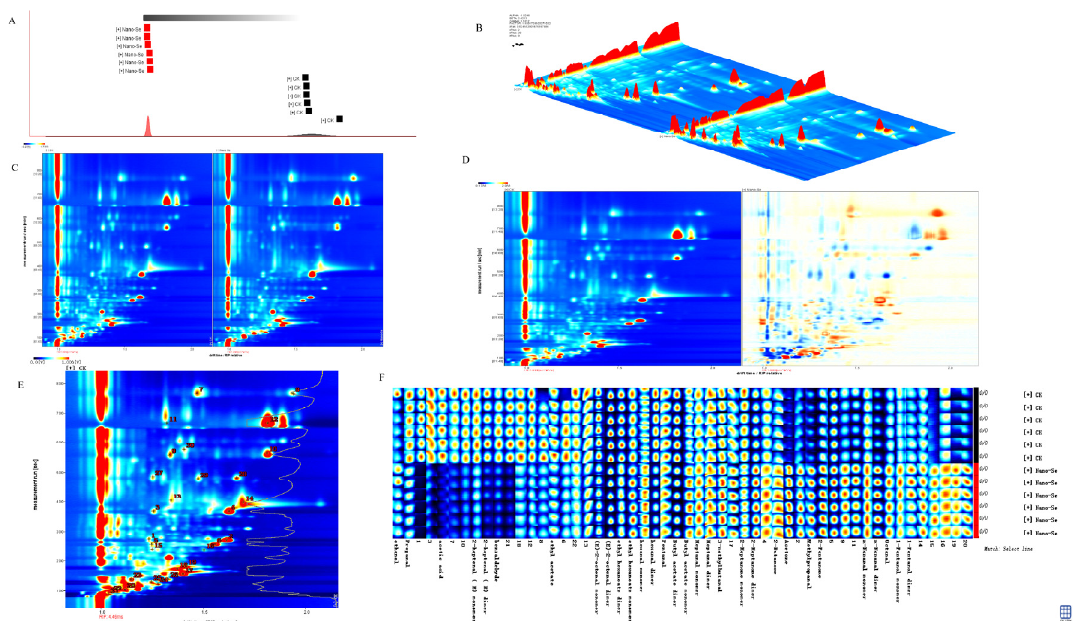
Figure 5. The PCA analysis ( A ), GC-IMS three-dimensional spectrum ( B ), vertical view ( C ), gas phase ion migration spectroscopy ( D ), qualitative result diagram of gas phase ion mobility spectrum ( E ), and gallery plot ( F ) by the nano-Se treatment of S. grosvenorii . Data are presented as mean ± SEM ( n = 3).